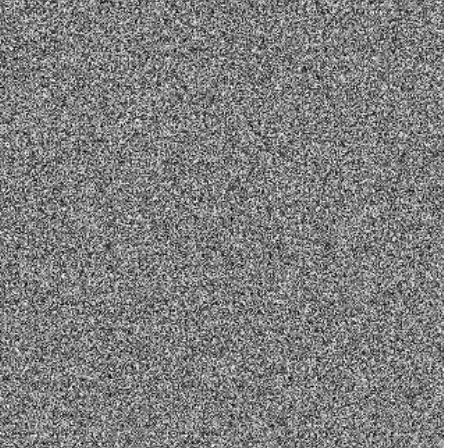
Figure 10. Nine ciphered images with Lorenz’ attractor and Arnold’s